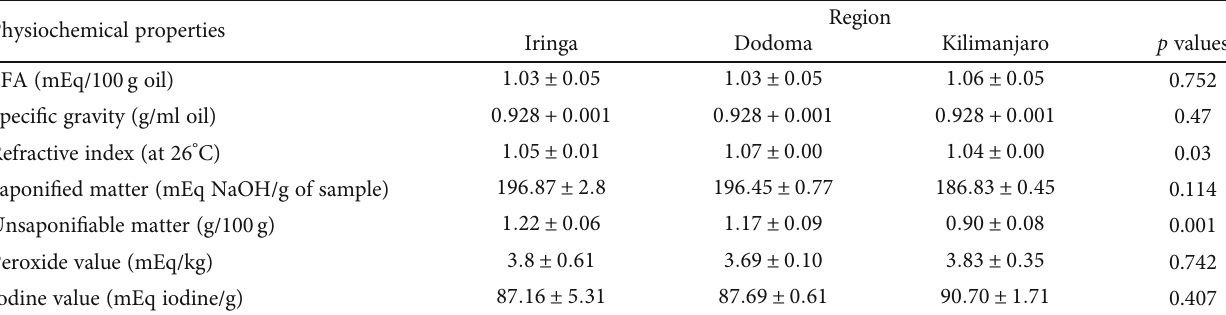
Table 2: Physicochemical properties of baobab seed